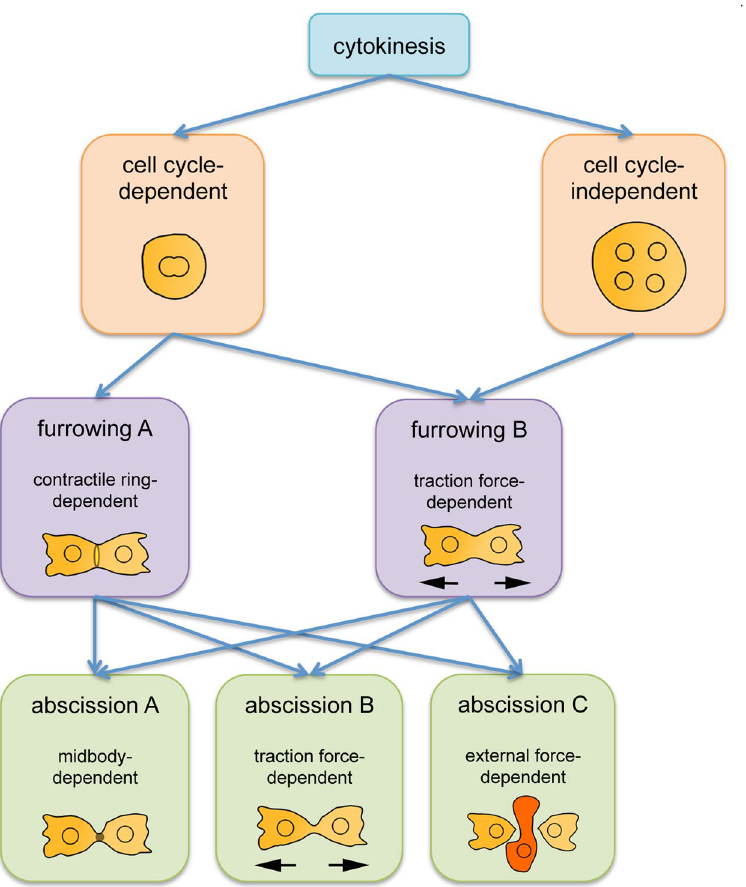
Figure 7. Classification of multiple modes of cytokinesis. There are two main categories: cell cycle-dependent and cell cycle-independent cytokinesis. The conventional process of cytokinesis C belongs to the latter. The furrowing step can be classified into two classes: contractile ring-dependent (furrowing A) and contractile ring-independent (furrowing B). The abscission step can be classified into three classes: midbody-dependent (abscission A), traction force-dependent (abscission B), and external force-dependent (abscission C). Most animal cells divide by furrowing A and abscission A. Wild-type Dictyostelium cells divide on the substratum by furrowing A and abscission B but divide in suspension by furrowing A and abscission C (with the shearing force of shaking as the external force). Myosin II-null cells divide on the substratum by furrowing B and abscission B. The friction-mediated process of cytokinesis observed in the present study might be classified as contractile ring-dependent (furrowing A) and traction force-dependent (abscission B). The cells dividing via conventional cytokinesis D (midwife-dependent cytokinesis) divide by furrowing A (or B) and abscission C (with a help of the external force provided by the midwife